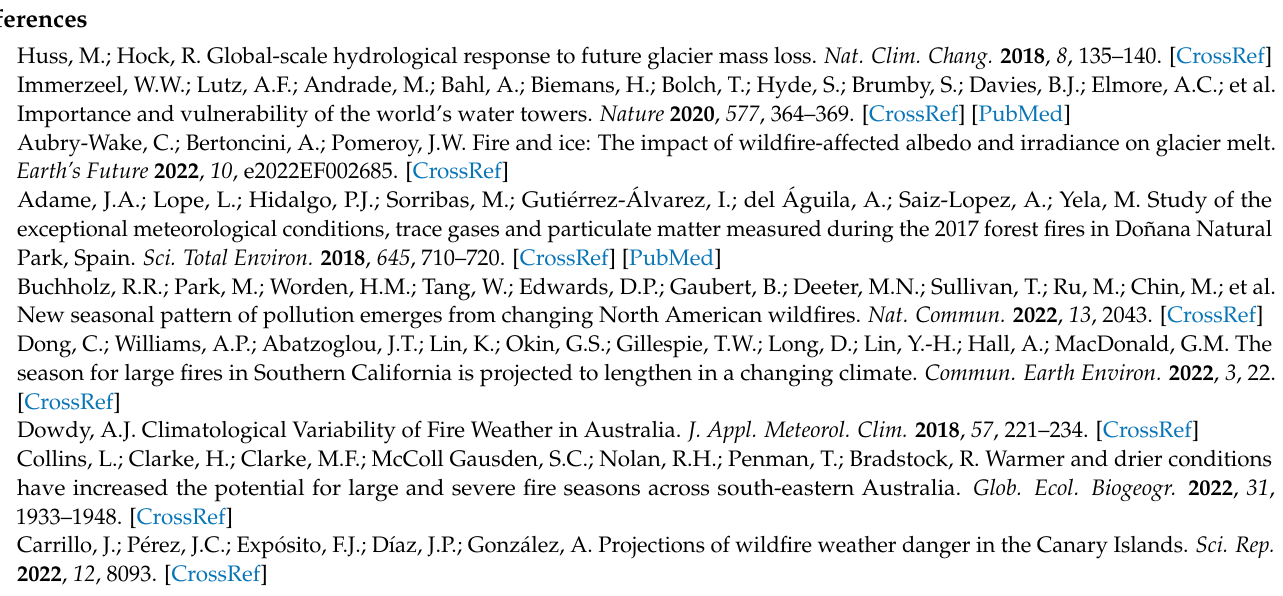
Figure S3. Total accumulated precipitation for 10 wintertime periods obtained from the